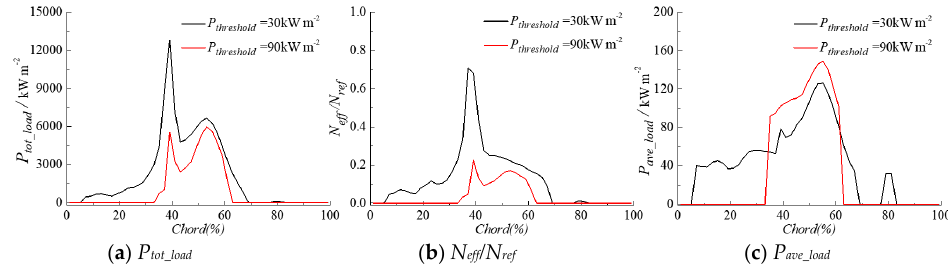
Figure 13. Distribution of P tot_load , N eff /N ref and P ave_load along the chord for P threshold levels of 30 and 90 kW m − 2 .